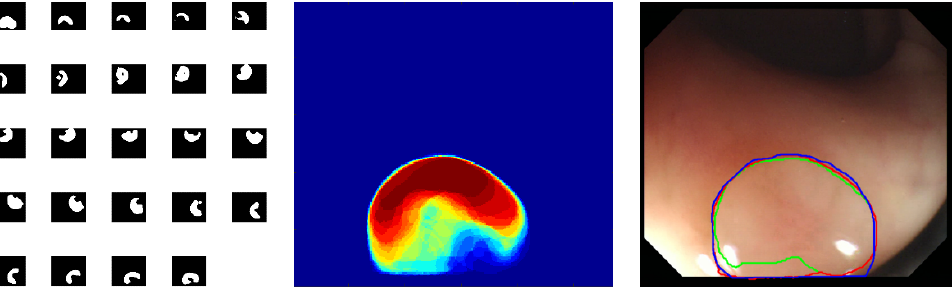
Figure 7. Graphical representation of the test time data augmentation; the images on the left show the network binary outputs for each rotation augmented image; the image in the middle shows the results of averaging of these binary images after transferring them into the original image reference frame; the image on the right shows final segmentation results, superimposed on the original image, with three contours showing ground truth (in blue), results without data augmentation (in green), and with the data augmentation (in red).